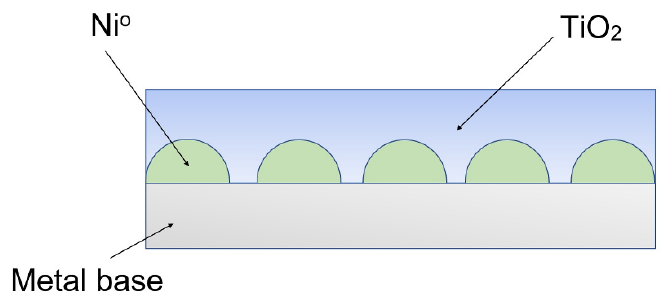
Figure 1. Scheme of formation of coatings.